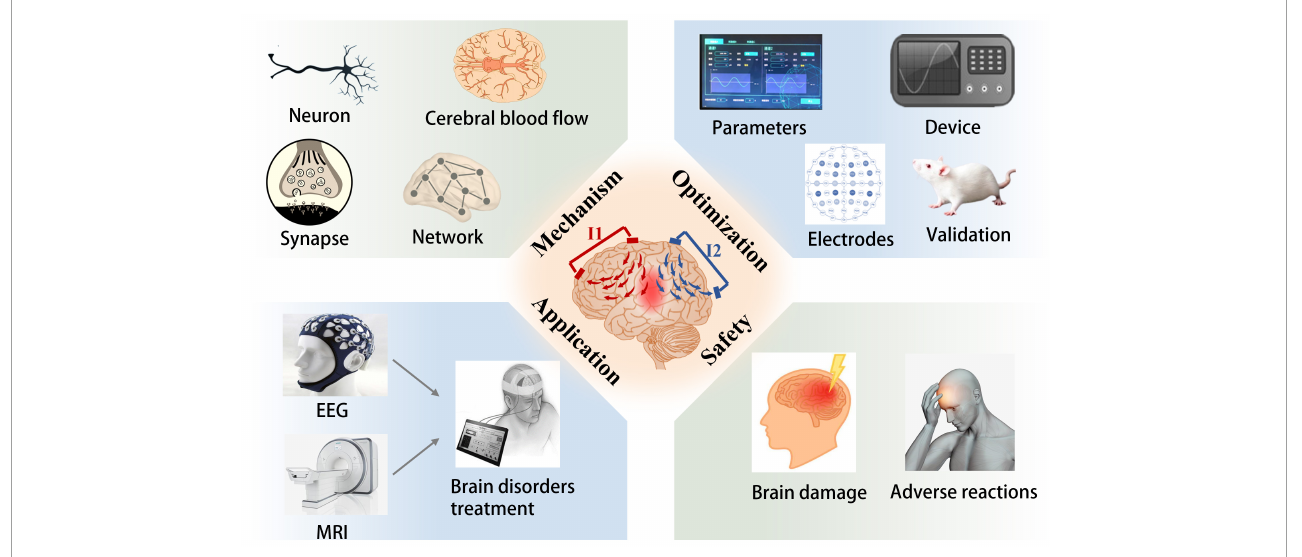
FIGURE3 Potential future directions for TI electrical stimulation, with four factors to consider: mechanism, optimization, application, and safety. The subgraph introduces the implicated or potential study direction of TI electrical